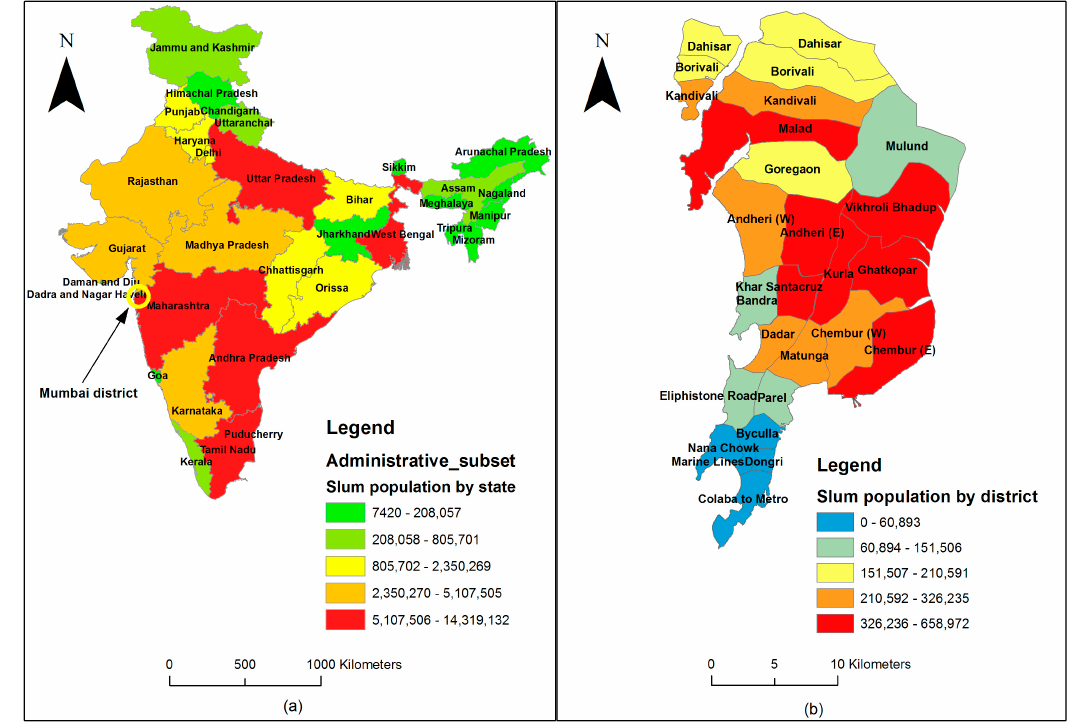
Figure 5. Geographic distribution of slums population in India ( a ) and Mumbai ( b ) (Data—India districts [148] and Mumbai wards